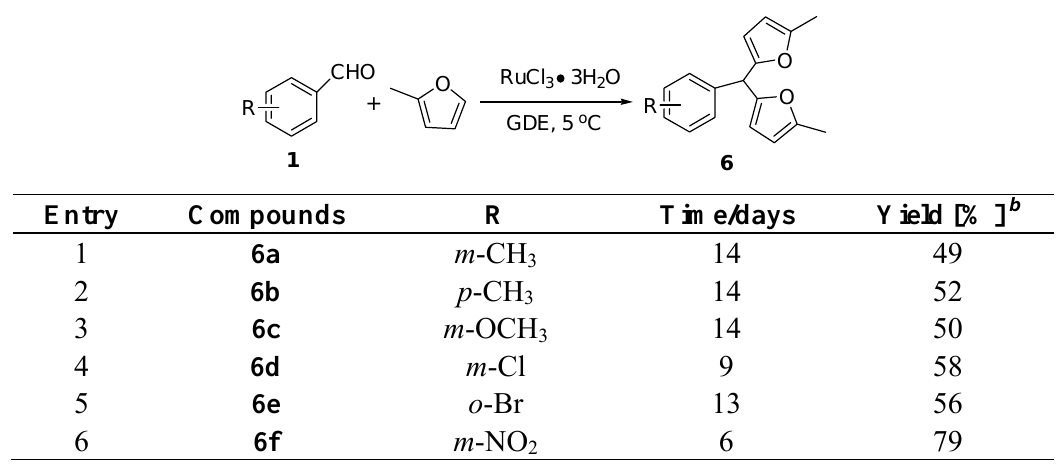
·3H O-catalyzed reaction of 2-methyl furan with aryl aldehydes a Table 4. RuCl 3 2